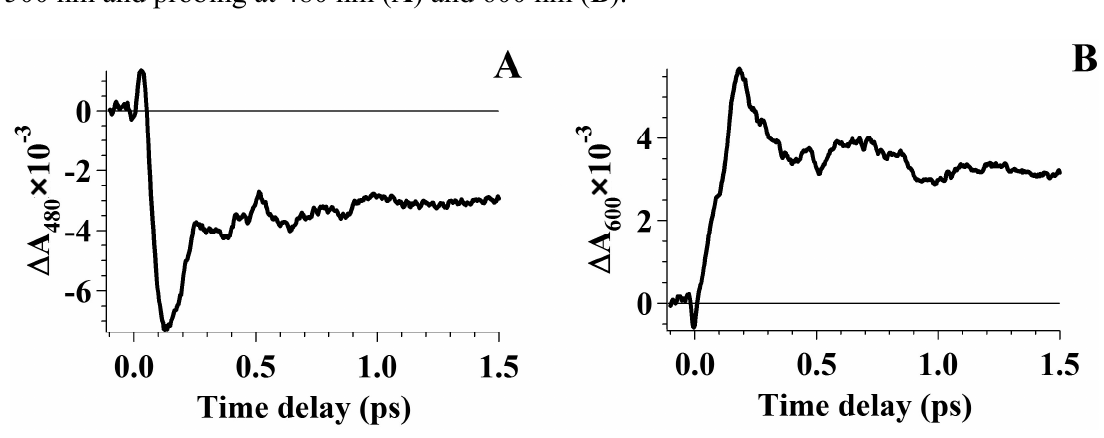
Figure 1. Transient photo-induced absorption kinetic curves of rhodopsin. The kinetic curves were documented by one-pump probe experiments with pumping by a 25 fs pulse at 500 nm and probing at 480 nm ( A ) and 600 nm ( B